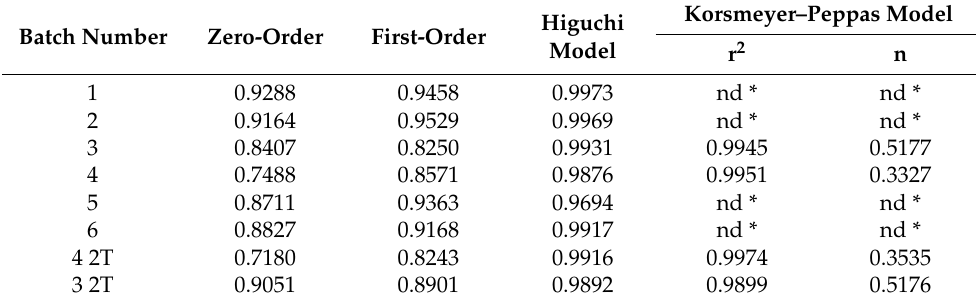
Table 5. Correlation coefficient (r 2 ) for different release models.